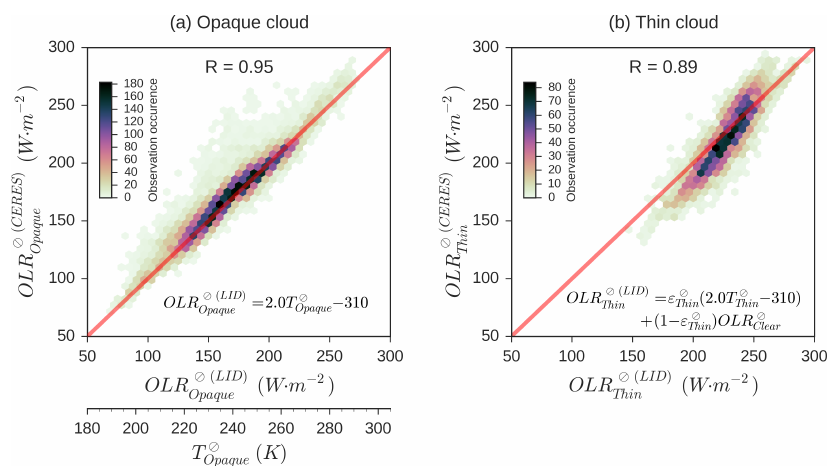
(cid:11) ( LID ) opaque